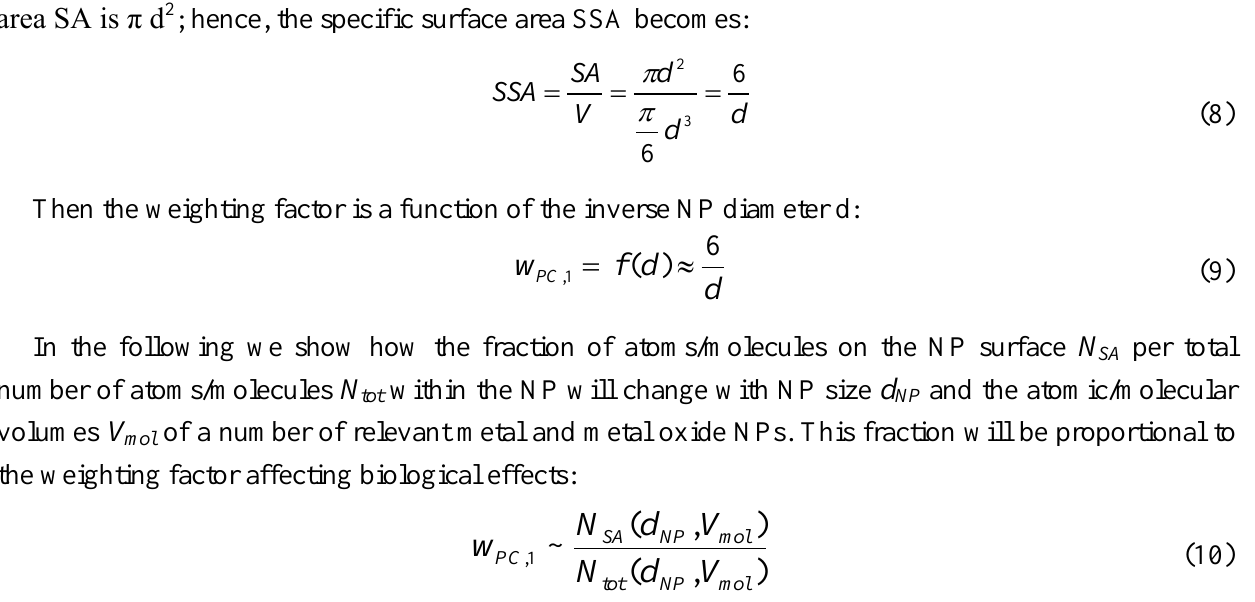
Figure 1a. Since the gold atoms are smaller than the silver atoms, the fraction of gold atoms on the surface is slightly lower compared to that of the silver